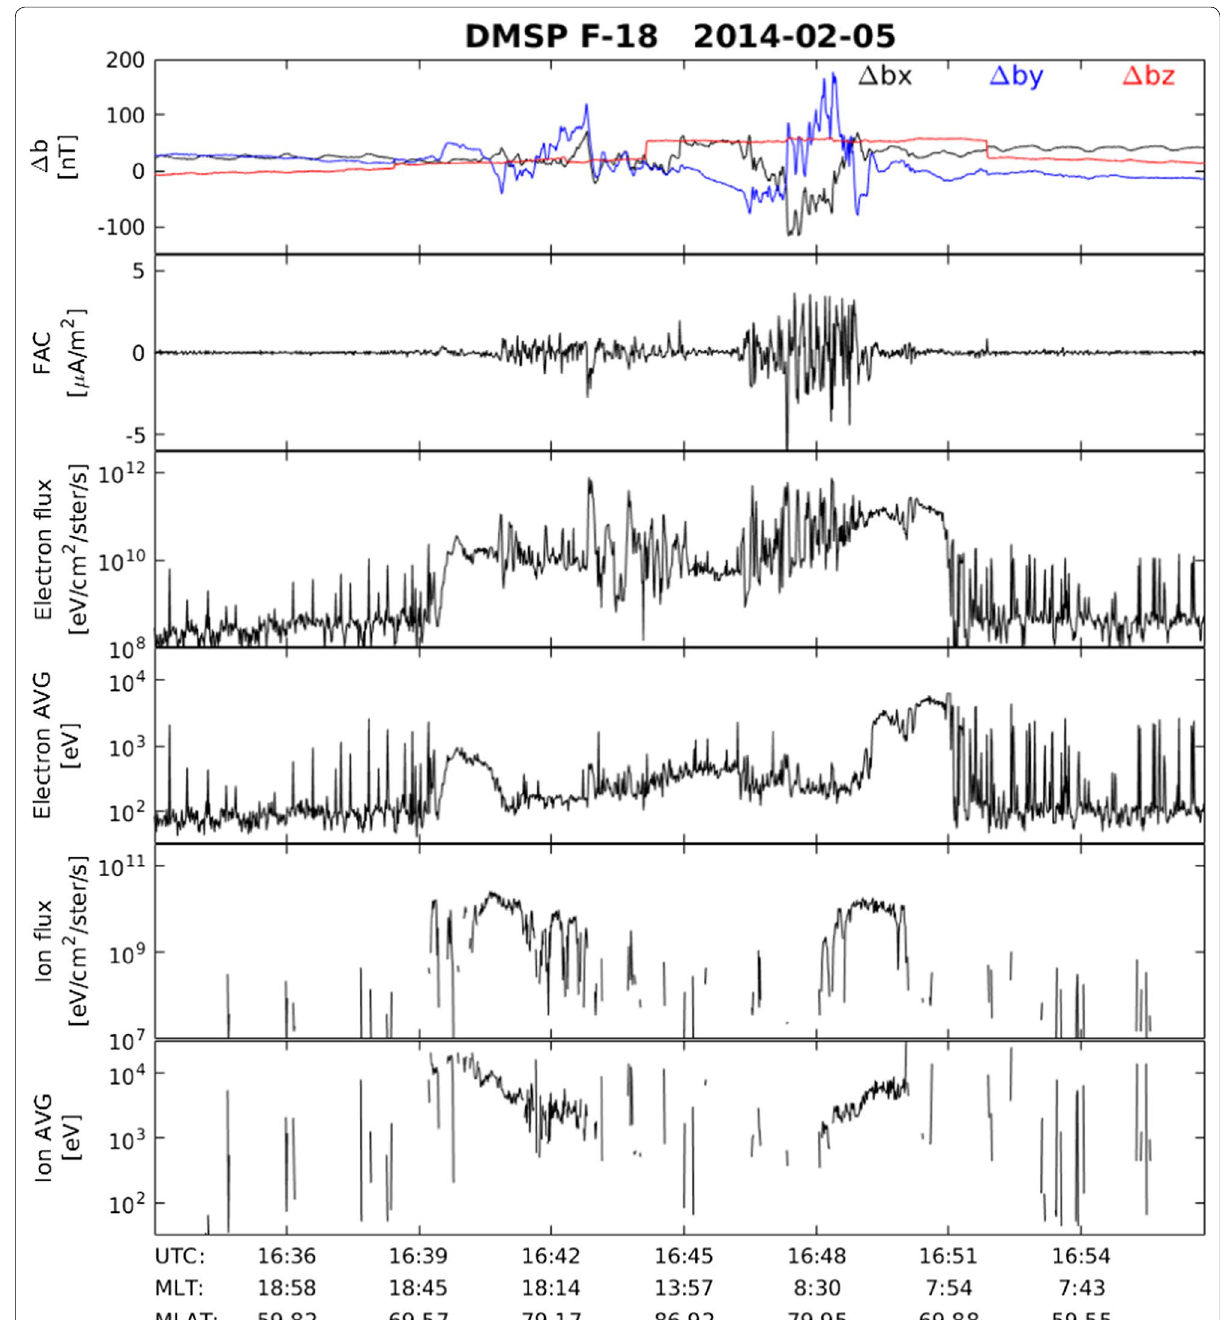
Fig. 2 Observations from one high-latitude orbit of DMSP F-18 around 16:45 coordinated universal time (UTC) on 5 February 2014. From top to the bottom, panels are the magnetic residuals, FACs, electron energy flux, electron average (AVG) energy, ion energy flux, and ion average